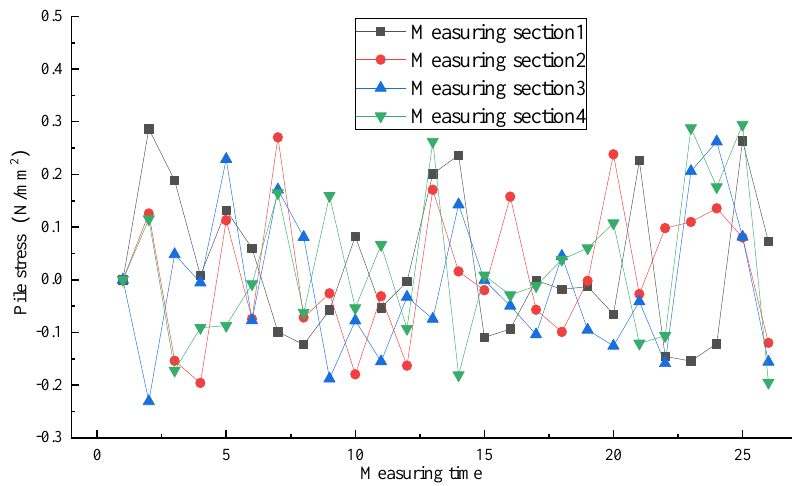
Figure 14. Stress gauging result of piles foundation.